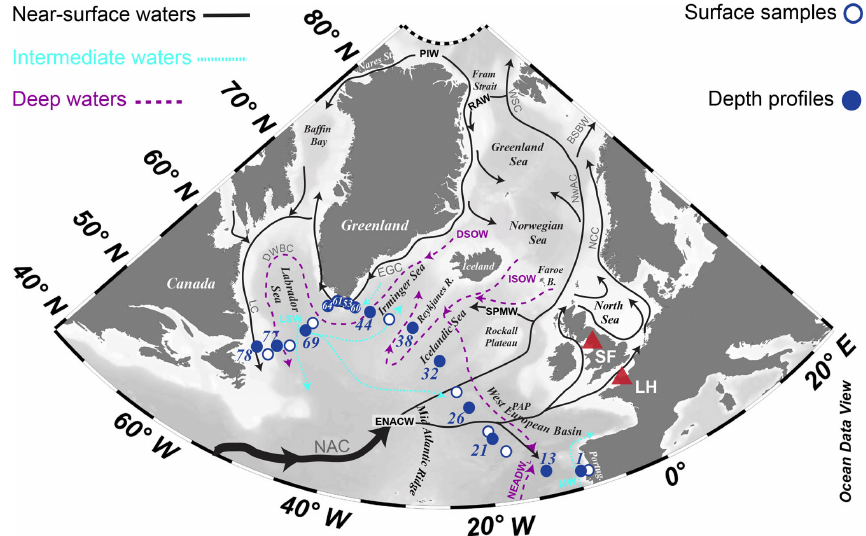
Figure 1. Sampled locations in the subpolar North Atlantic during the GEOVIDE cruise in spring 2014. The nuclear fuel reprocessing plants of La Hague (LH) and Sellafield (SF) are represented along with the main water masses and their schematic spreading pathways are adapted from Daniault et al. (2016) and Smith et al. (2005). Acronyms are defined in the